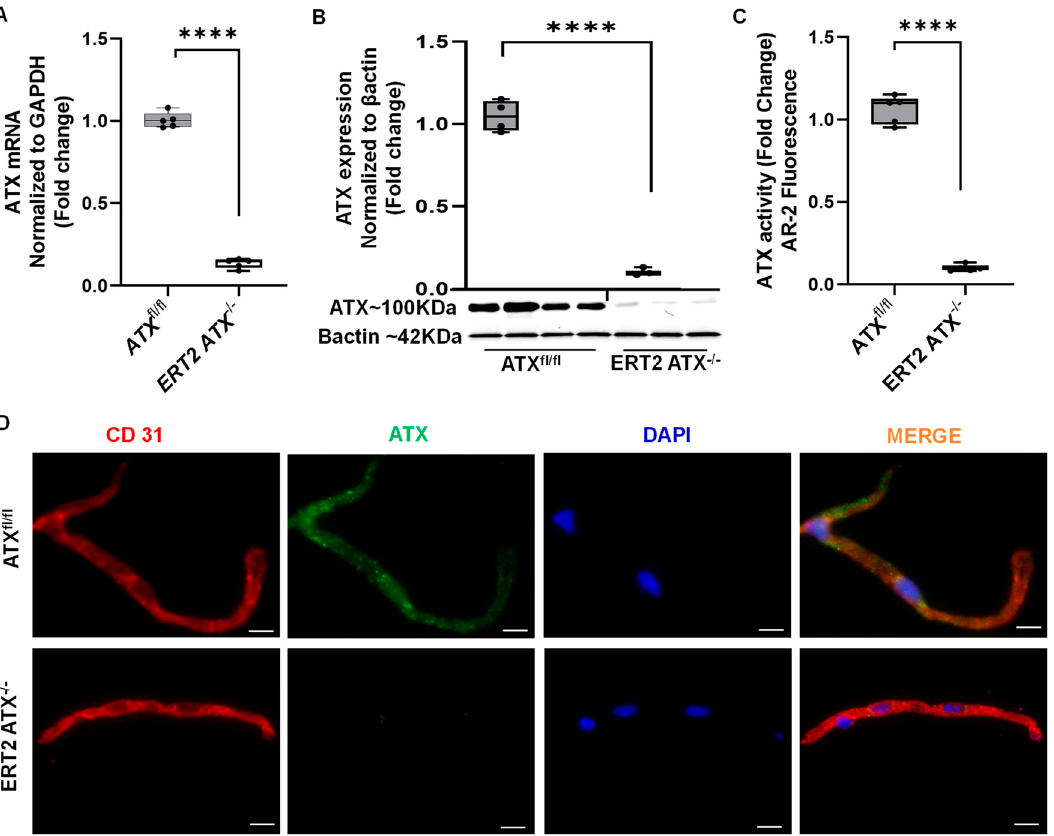
Figure 2. Tamoxifen-inducible Tie2-Cre-mediated inactivation of ATX lowers ATX expression in the brain microvasculature. ( A ) ATX mRNA expression was measured in brain microvascular tissue from ATX fl/fl and ERT2 ATX − / − mice and reported relative to the values in ATX fl/fl in brain microvascular tissue (mean ± SEM from n = 5 animals per genotype). ( B ) Immunoblot analysis of ATX expression in brain microvascular tissue with actin used as a loading control. ATX expression was normalized to actin staining ( n = 3–4 animals) and presented as mean ± SEM in arbitrary units, in which the density of ATX in the ATX fl/fl samples was set to 1. ( C ) ATX activity determined in brain microvascular tissue using the AR-2 probe ( n = 5 animals per genotype). Results are reported as the fold change in which the RFU of ATX in the ATX fl/fl samples was set to 1 (mean ± SEM; n = 5 mice per genotype). ( D ) Representative images of immunostaining for CD31 (red) and ATX (green) in isolated brain microvascular tissue, whereas endothelial CD31 and ATX expression overlap in ATX fl/fl brain microvascular tissue (magenta color) in ERT2 ATX − / − mice. Scale bar = 100 μ m.**** p < 0.0001 by t -test versus control.